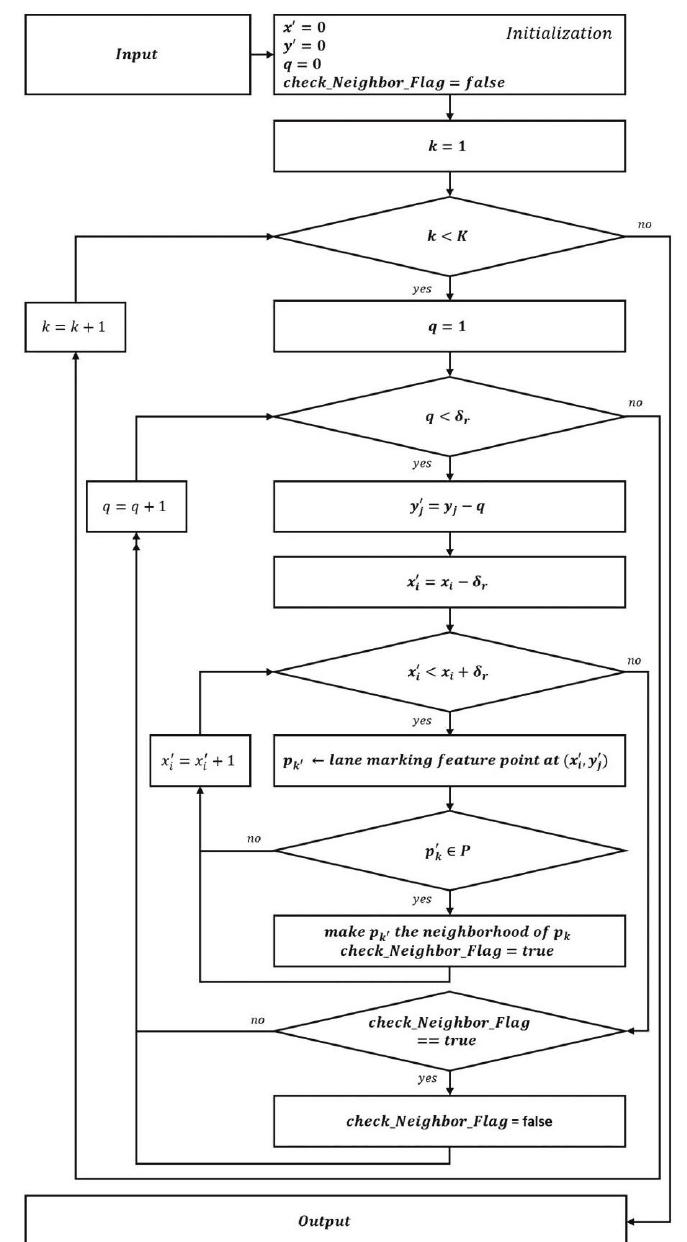
Figure 5. Diagram for finding